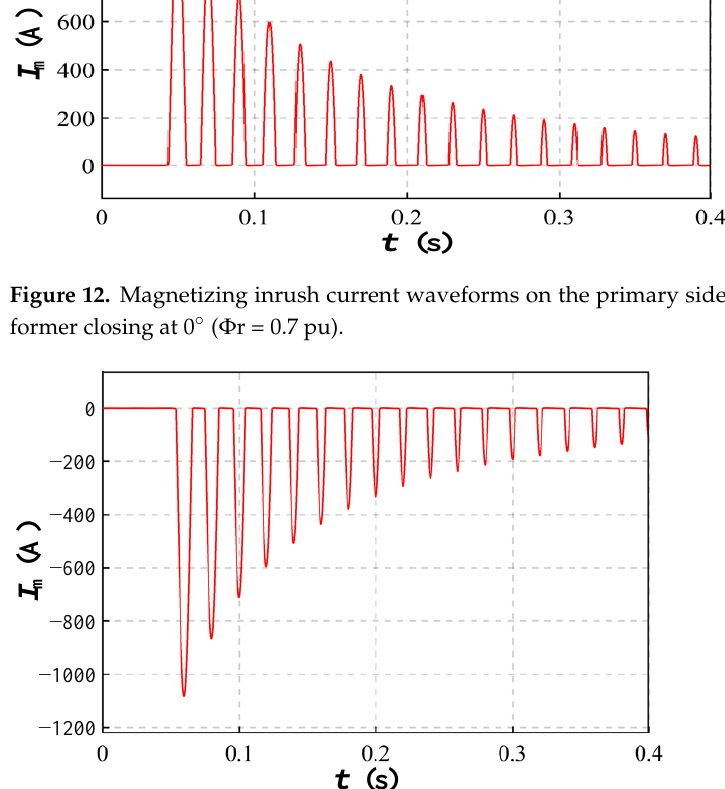
Figure 13. Magnetizing inrush current waveform on the primary side of the vehicle-mounted transformer when closing at 180° (Φ r = 0.7 pu).